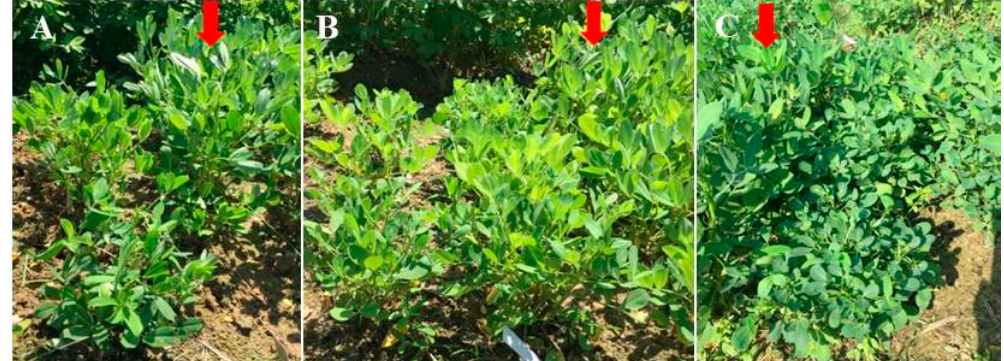
Figure 6. Mutants with dwarf and small-size leaves of HY22 and YY45. ( A and B ) Mutants of HY22; ( C ) Mutants of YY45. Red arrows indicate the corresponding control.